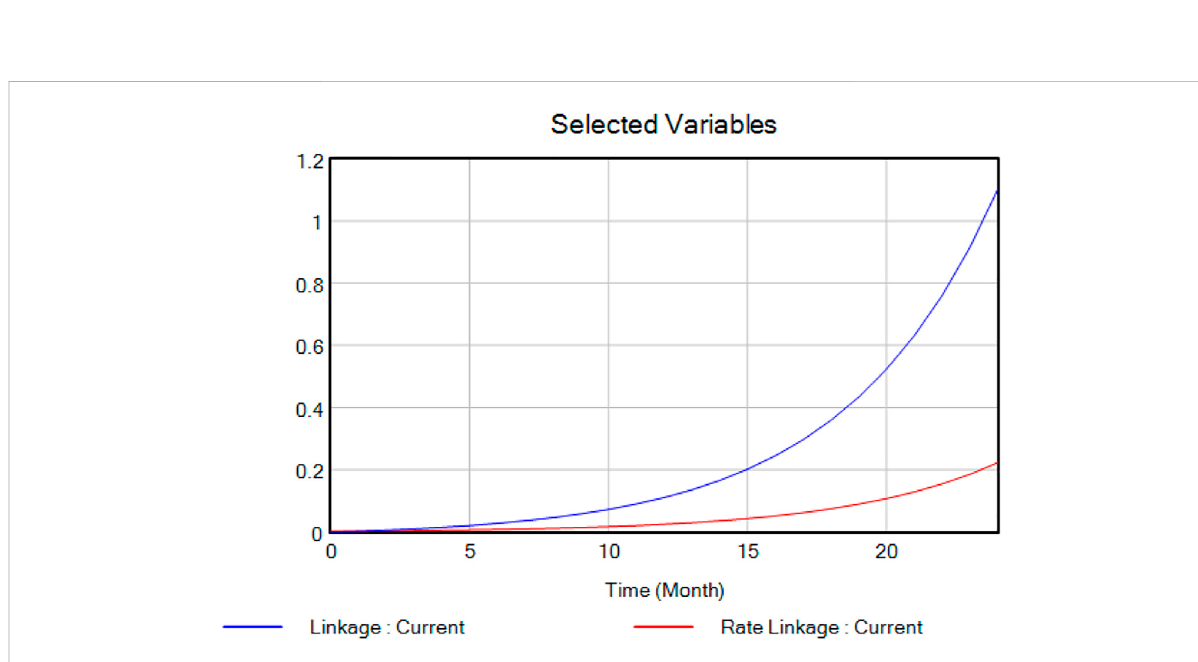
FIGURE 8 Causal strip diagram variable linkage (intermediation) source: Data processing results, 2022.